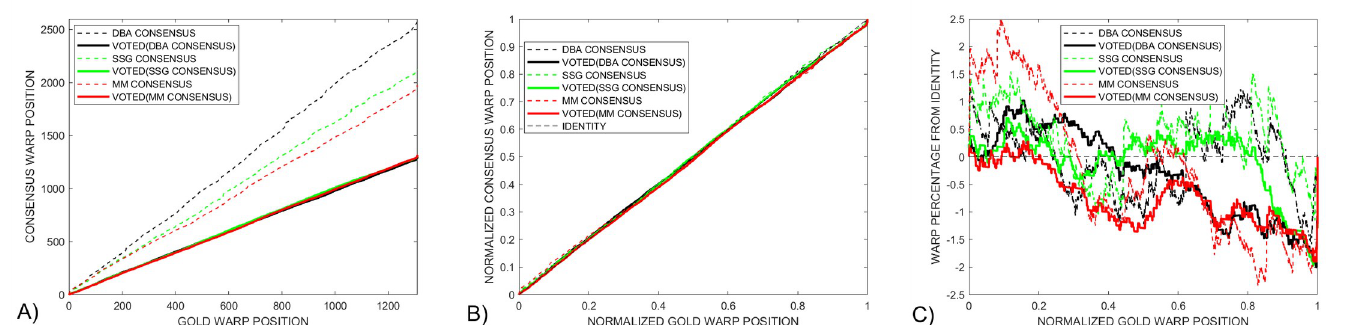
Fig 9. Dotted and solid lines respectively indicate warping paths before and after voting. The different DTWA consensus warping paths collapse together in both A) the standard and B) normalized warp path displays. C) Linear sections in the Differences-from-Identity metric after voting indicate that the SSG consensus green, is similar to the gold standard between 20% to 80% of the warp path and the DBA consensus, black, is similar between 10% and 99% of the warp path. Several straight sections in the MM consensus, red, indicate where this signal is most similar to the gold signal.